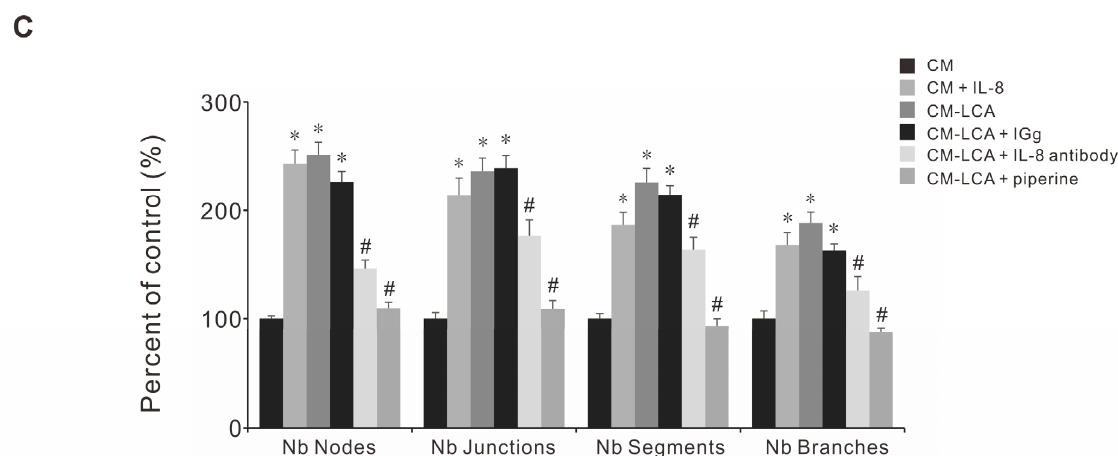
Figure 6. Effect of CM Obtained from the Piperine-Pretreated and LCA-Treated HCT-116 Cells on EA. hy926 for Tube Formation. EA. hy926 cells grown on a Matrigel-coated plate for 24 h were incubated with CM solutions. After 6 h, the cells were observed and counted using a Nokia microscope. ( A ) Representativeimages (10×) of the EA. hy926 tube formation. ( B,C ) Quantitative data of the EA. hy 926 tube formation. Data represent the mean ± SEM from three experimental trials. * p < 0.05 versus control; # p < 0.05 versus